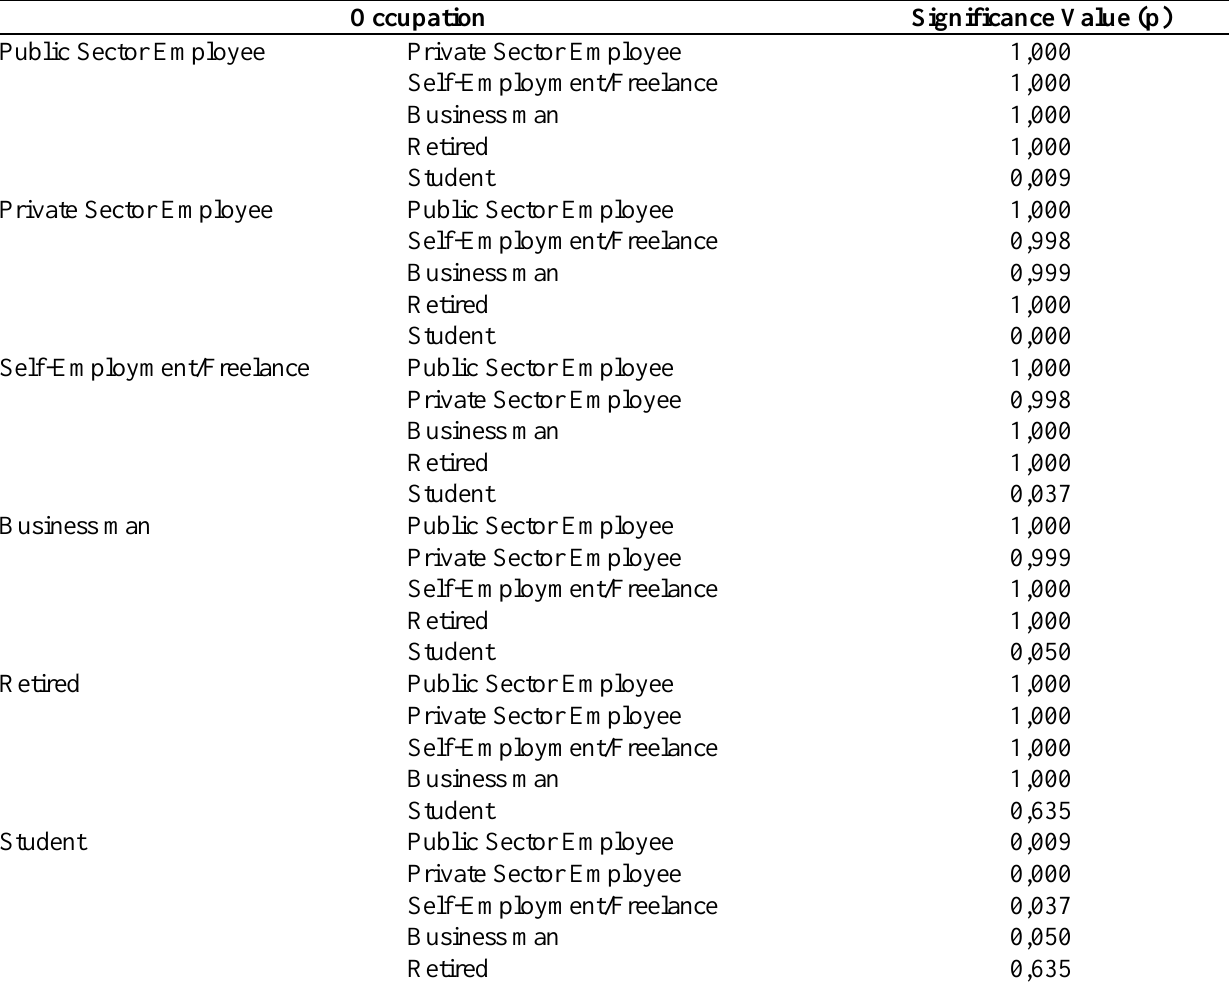
Table 12. Multiple comparison of profession and other rewards/services - Tukey test – results Occupation Significance Value (p)